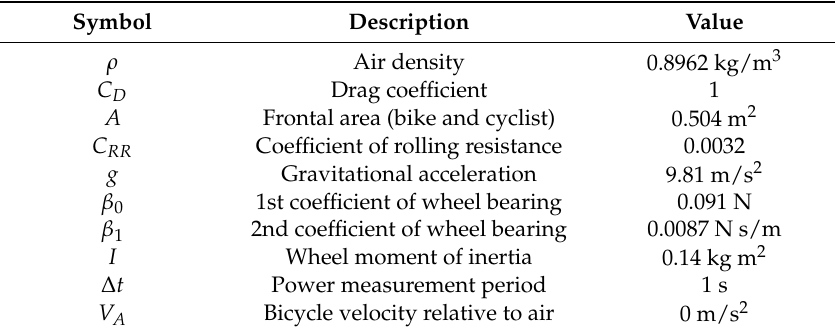
Table 2. Average parameter